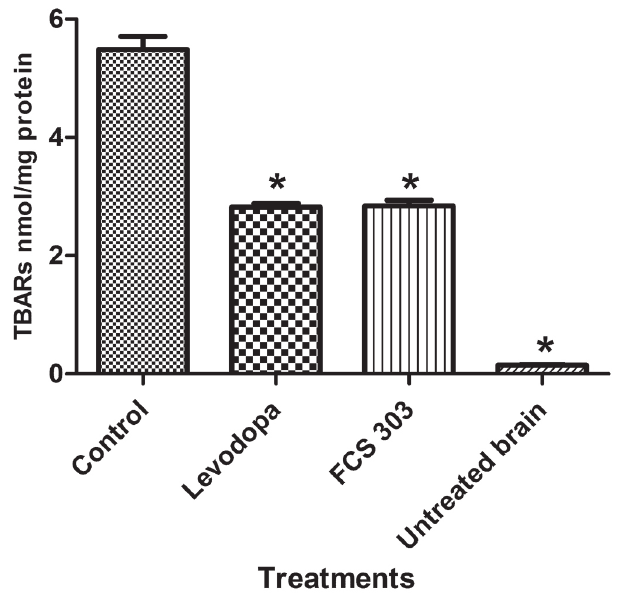
FIGURE 6 - Effect of administration of FCS303 (50 mg/kg), control (vehicle 0.1 mL/10 g body weight), or levodopa/ carbidopa (400/40 mg/kg) on lipid peroxidation in brain homogenates of mice treated with haloperidol (1 mg/kg) for 10 days. n = 8 mice. *p < 0.05 compared to the control group.